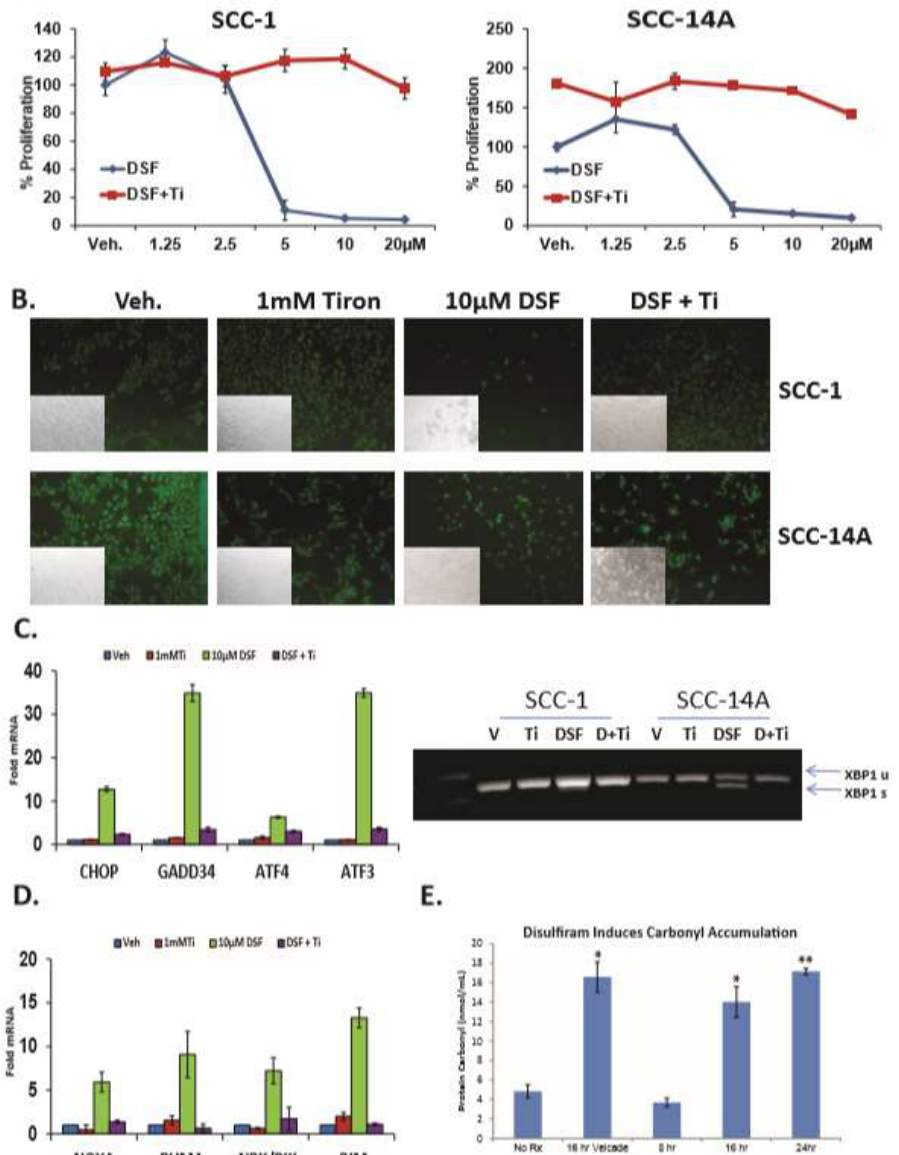
Figure 4. DSF-mediated reactive oxygen species ROS are required for UPR activation and leads to oxidative protein damage. ( A ), Proliferation assays with oral (OSCC) cells treated with increasing concentrations of DSF in the presence or absence of the superoxide scavenger tiron (Ti) for 24h, error bars represent standard deviation. ( B ), Identically treated cells stained with fluorescent dyes to appreciate live cells (green) and dead cells (red) after 24 h. ( C ), RT-qPCR (left) and RT-PCR (right) to appreciate UPR genes in OSCC cells treated with 10 µ M DSF +/ − tiron for 6 h. ( D ), RT-qPCR analysis of the same cDNA libraries as in ( C ) for apoptotic transcripts. ( E ), Analysis of carbonyl accumulation as a marker of protein damage in 10 µ M DSF treated OSCC cells (8–24 h), as indicated; error bars represent standard deviation, two-tailed test: * p ≤ 0.05, ** p ≤ 0.01, *** p ≤